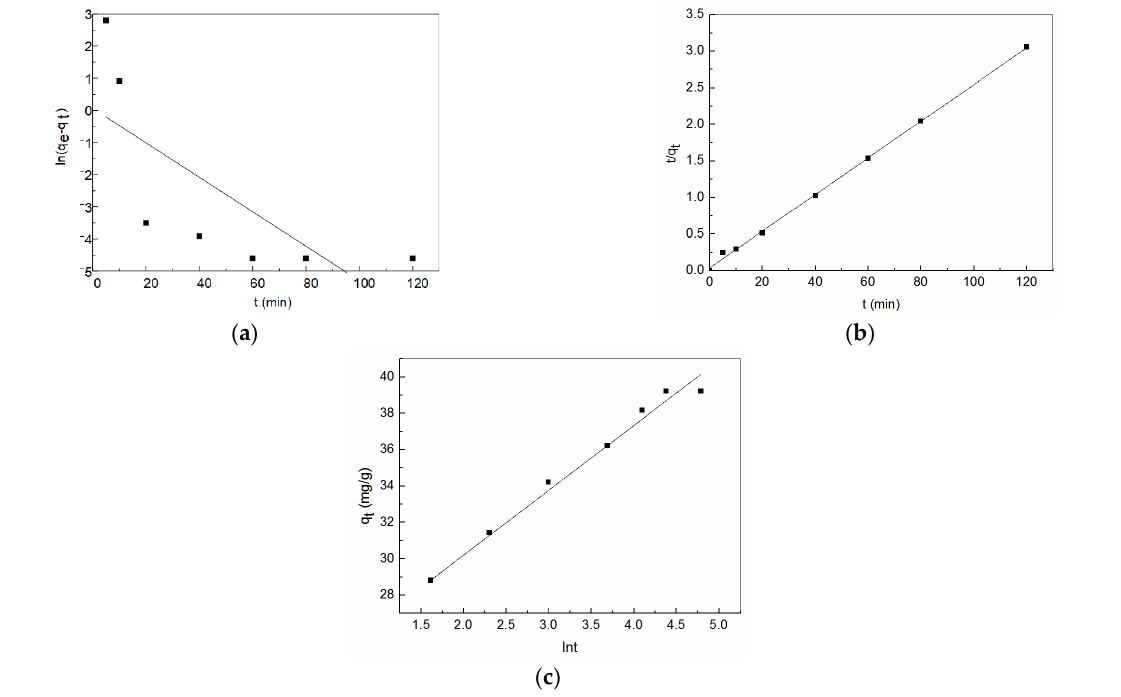
Figure 8. ( a ) Linear fit of pseudo ‐ first order equation; ( b ) Linear fit of pseudo ‐ second order equation; and ( c ) Linear fit of Elovich equation. Table 1. Kinetic constants for adsorption of Zn 2+ ions.